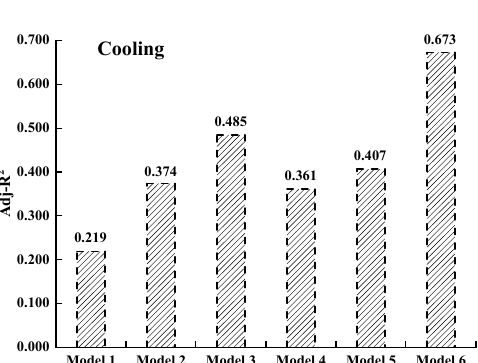
representing the change value of the dependent variable when the independent variable increased by 1 unit, Std. error, Standard Error of regression model; t-Sig, Significance value of regression analysis of each independent variable test one by one. When the value of t-Sig < 0.05, the β was statistically significant.